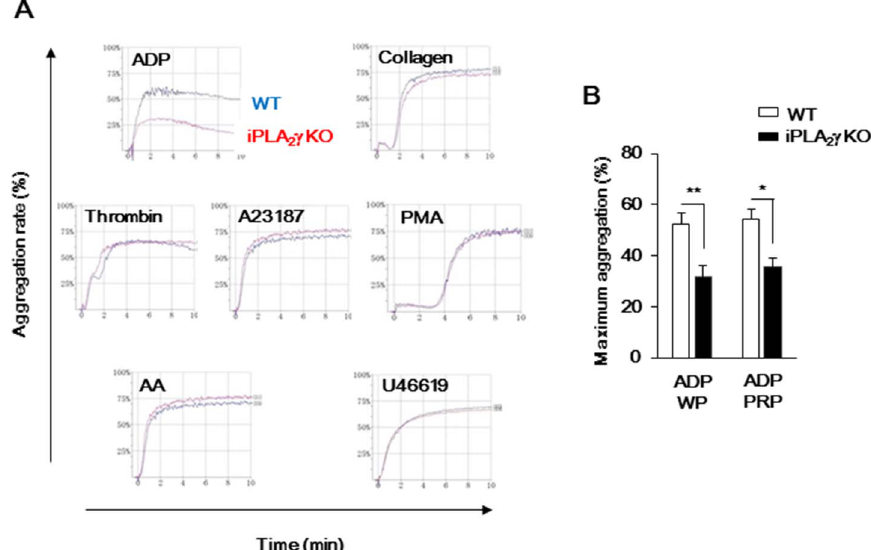
Figure 2. iPLA 2 c deficiency inhibits platelet aggregation in response to ADP stimulation. (A) Representative results from aggregometry testing. Washed platelets from WT (blue) or iPLA 2 c -KO (red) mice were stimulated with the indicated agonists (ADP (10 m M), collagen (1 m g/ml), thrombin (0.1 U/ml), A23187 (5 m M), PMA (10 nM), AA (100 m M) or U46619 (5 m M)), and then light transmission was recorded on an aggregometer. (B) Bar graphs indicate results obtained by aggregometry tests. Washed platelets (WP) or platelets in PRP (200 6 10 3 / m l) from WT or iPLA 2 c -KO mice were stimulated with ADP (10 m M), and then light transmission was recorded on an aggregometer. Results are given as the mean percentage of maximum aggregation 6 SEM (n=6–10). * P , 0.05 and ** P , 0.01 between iPLA 2 c -KO and